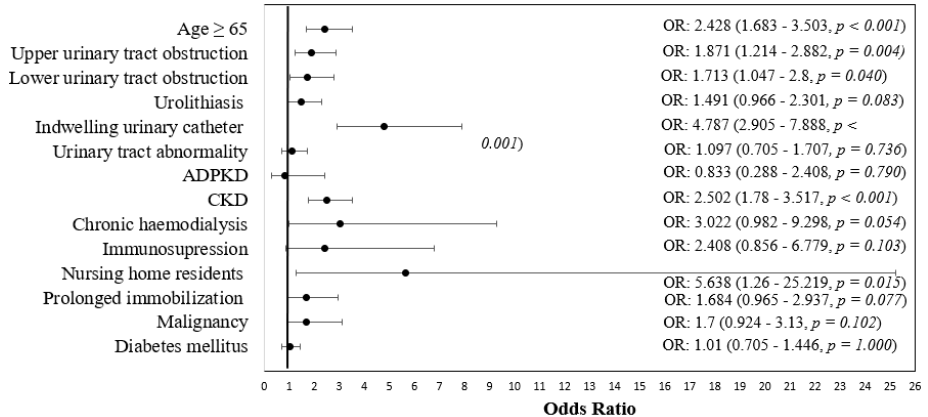
Figure 1. Forest plot for odds ratio with 95% confidence intervals univariate analysis of risk factors for general antibiotic resistance.